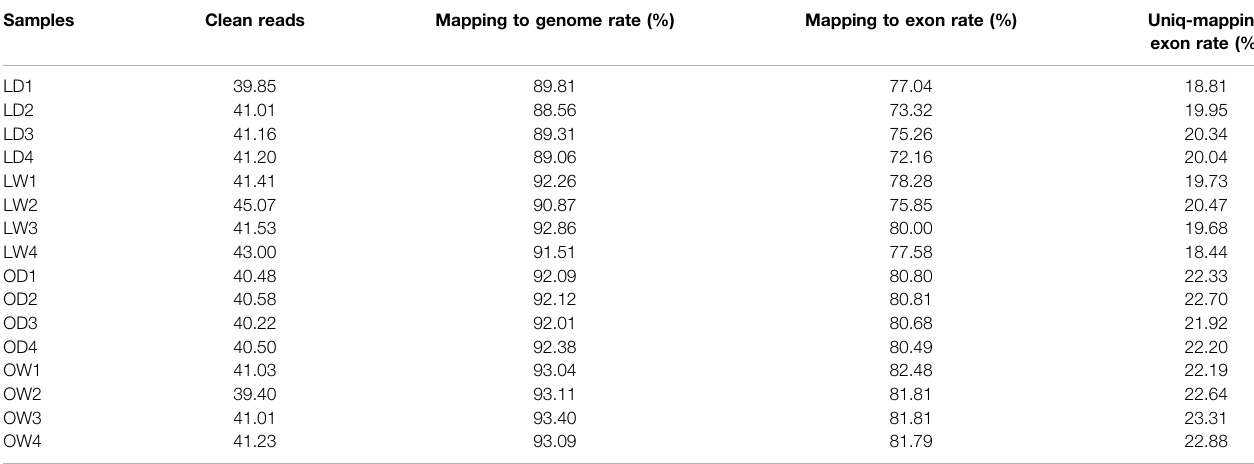
TABLE 2 | Summary of RNA-seq reads mapping to reference genome. Samples